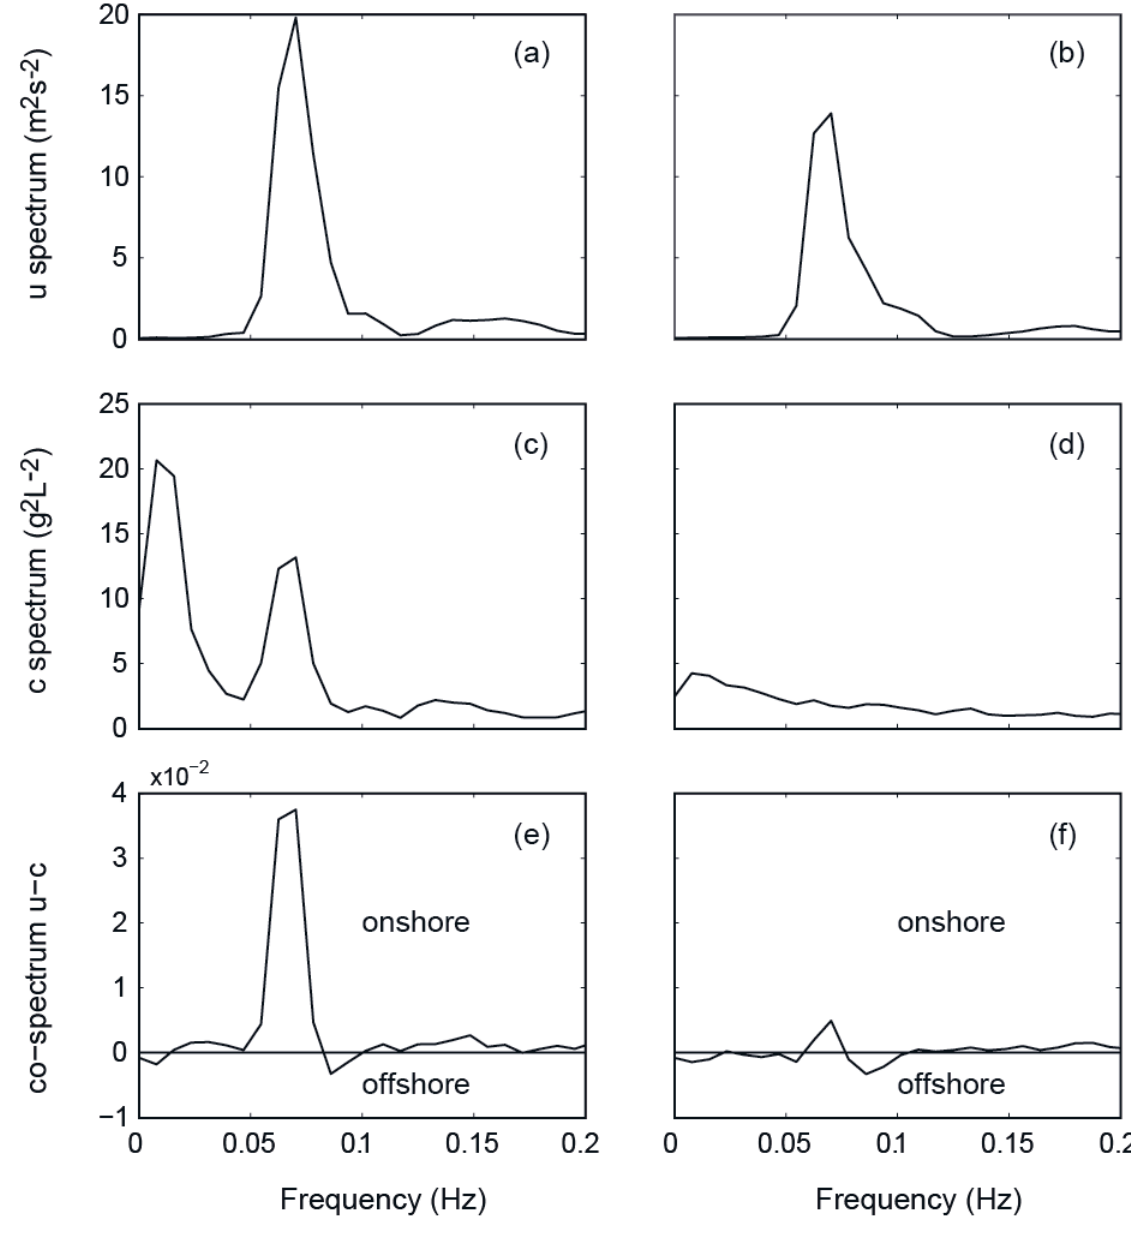
Figure 11. Results of spectral analysis between u and c ( a , c , e ) just under the surging/plunging breaker line: ( a ) u spectrum, ( c ) c spectrum, ( e ) c - u co-spectrum; and ( b , d , f ) 2 m shoreward of the breaker line: ( b ) u spectrum, ( d ) c spectrum, ( f ) c - u co-spectrum; Ambakandawila Beach, Chilaw, Sri